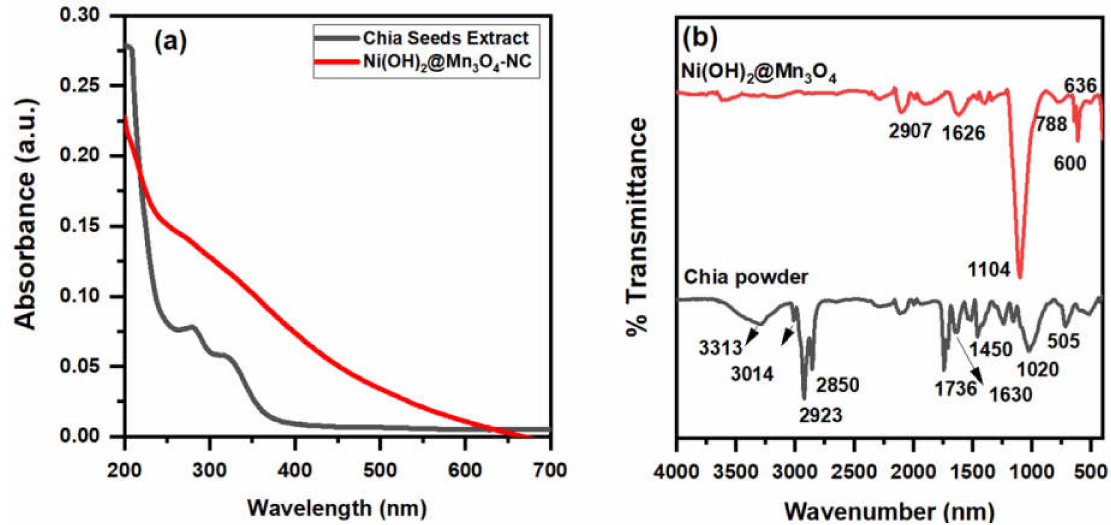
Figure 1. ( a ) FT-IR and ( b ) UV-Vis spectra for chia powder and Ni(OH) 2 @Mn 3 O 4 -NC. FT-IR